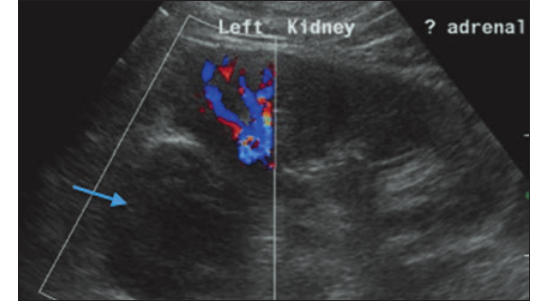
Fig. 2. Axial in-phase (IP) and opposed-phase (OP) chemical shift MRI images of a lipid- rich adenoma. Intralesional signal loss is demonstrated on the opposed-phase image (red arrow) compared with the in-phase image (blue arrow). (S = spleen.)